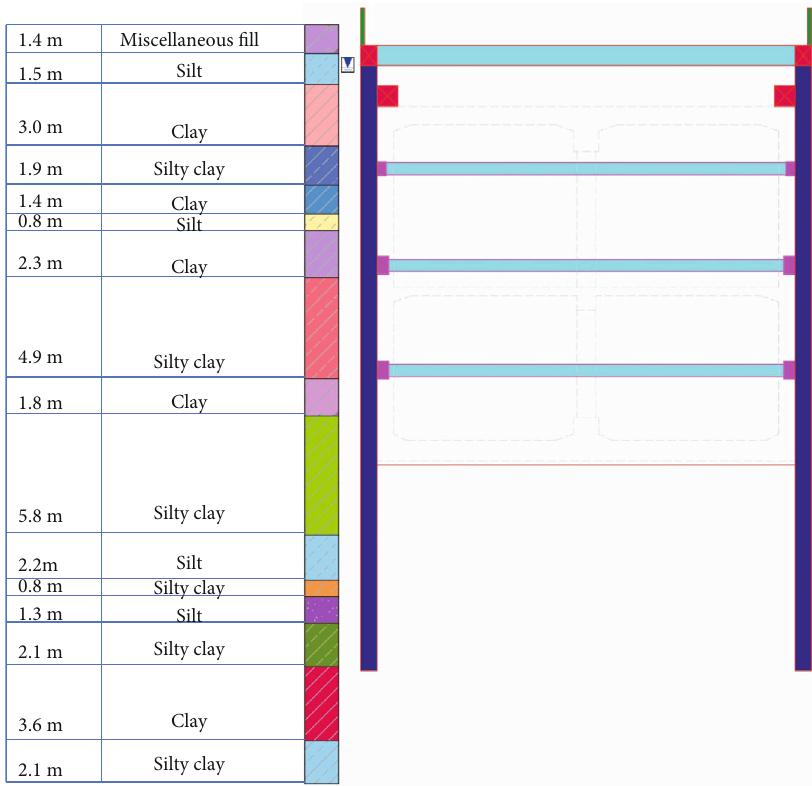
Figure 3: Soil pro fi le compared to the depth of the tunnel supports.